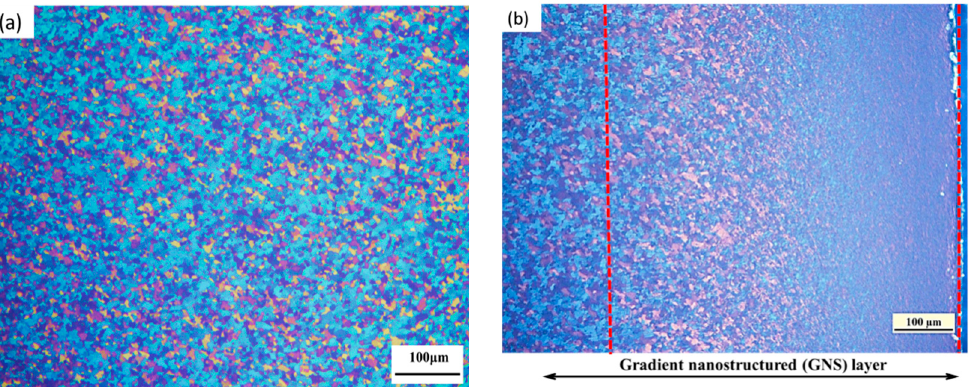
Figure 2. The microstructures of ( a ) as-received samples (CG Zr-4); ( b ) the cross section of Zr-4 alloy after SMGT (SMGTed Zr-4).